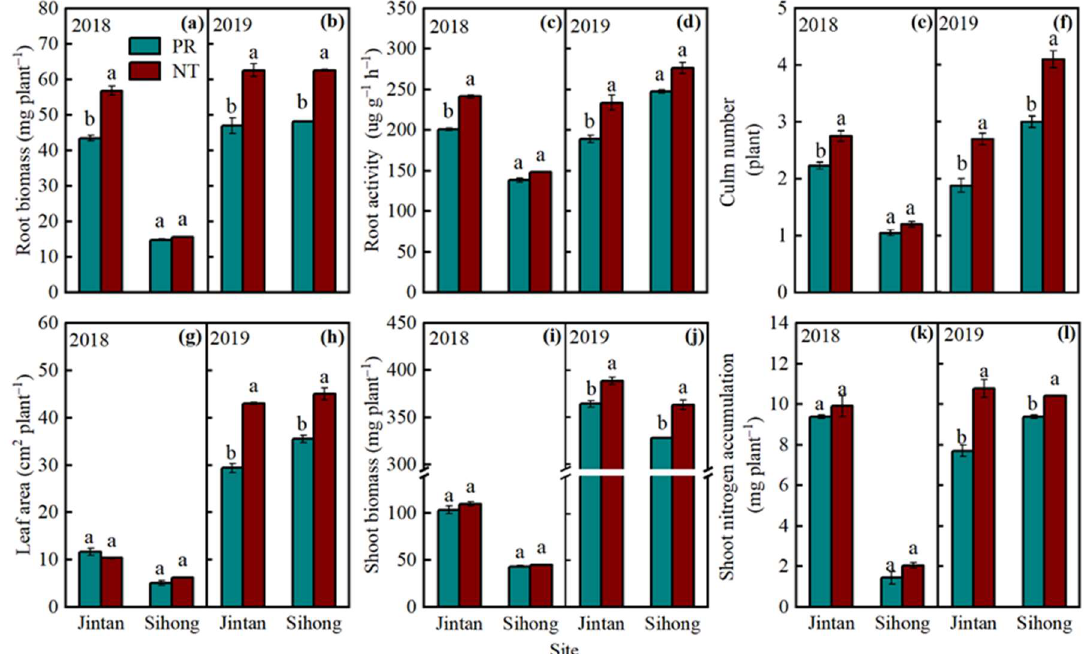
Figure 7. Effects of tillage practices on root biomass ( a , b ), root activity ( c , d ), culm number ( e , f ), leaf area ( g , h ), shoot biomass ( i , j ) and shoot nitrogen accumulation ( k , l ) of wheat seedlings at Jintan and Sihong in 2017–2018 and 2018–2019. Tillage methods included plow tillage followed by rotary tillage (PR) and no-tillage (NT). All values are presented as mean ± SE (3 replicates) with one standard error. Bars labeled with different letters indicate significant differences between tillage practices at the p < 0.05 level.